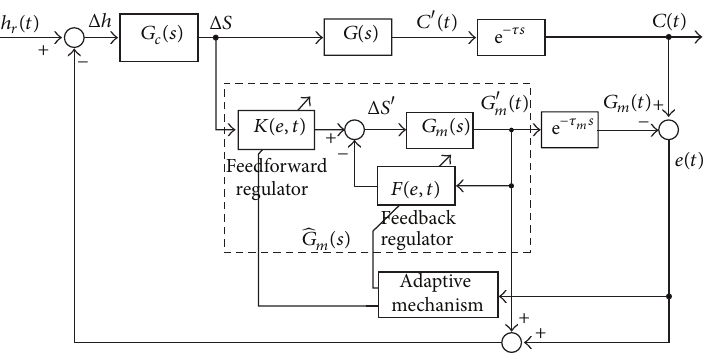
Figure 4: AGC control process based on adaptive Smith